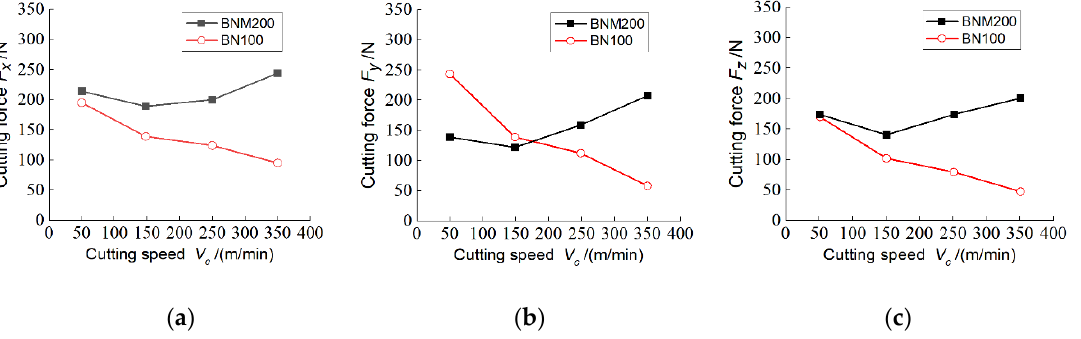
Figure 2. Effect of cutting speed on cutting force: ( a ) Radial force; ( b ) Force in feed direction; ( c ) Axial force.